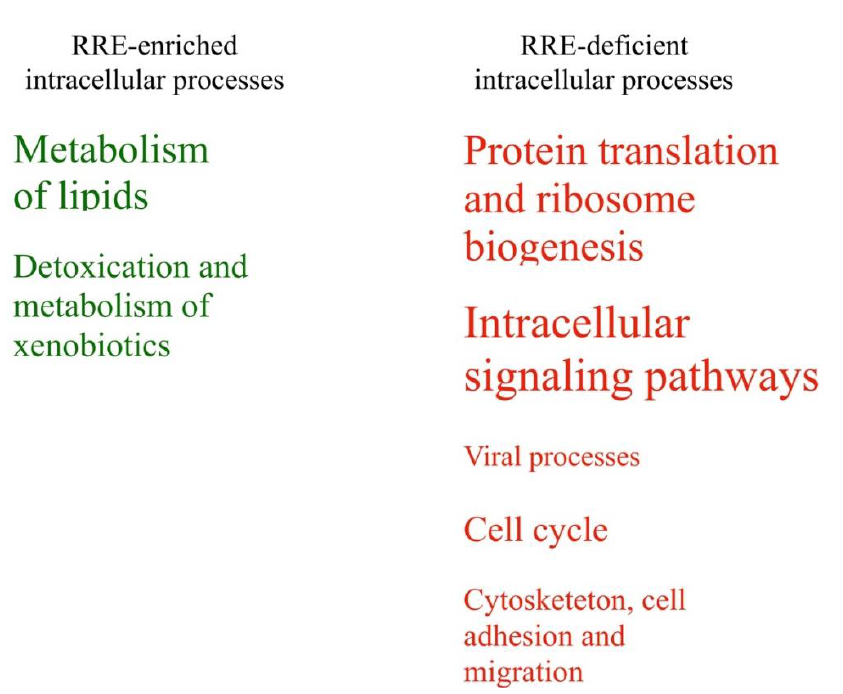
Figure 10. RRE-enriched and RRE-deficient molecular processes for evolutionary young Res.